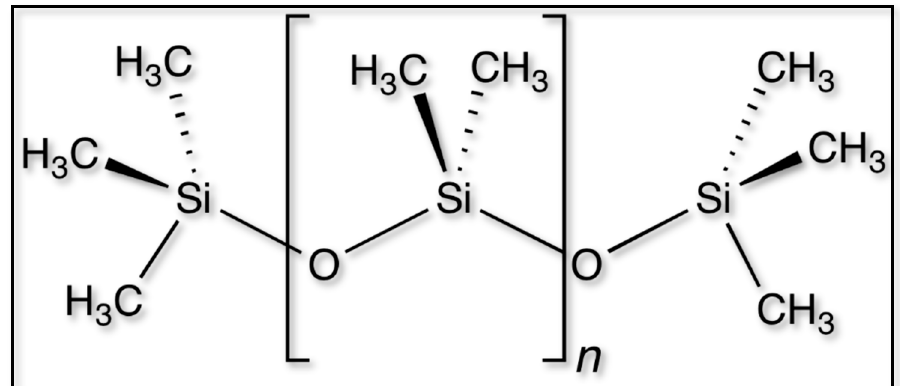
Figure 1. PDMS polymeric structure [33].